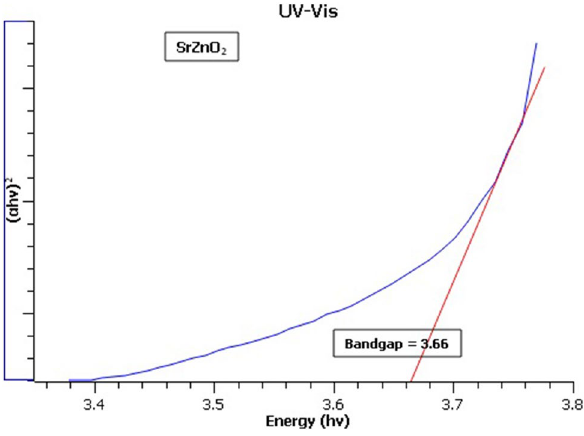
Fig. 7 UV–Vis results of SrZnO